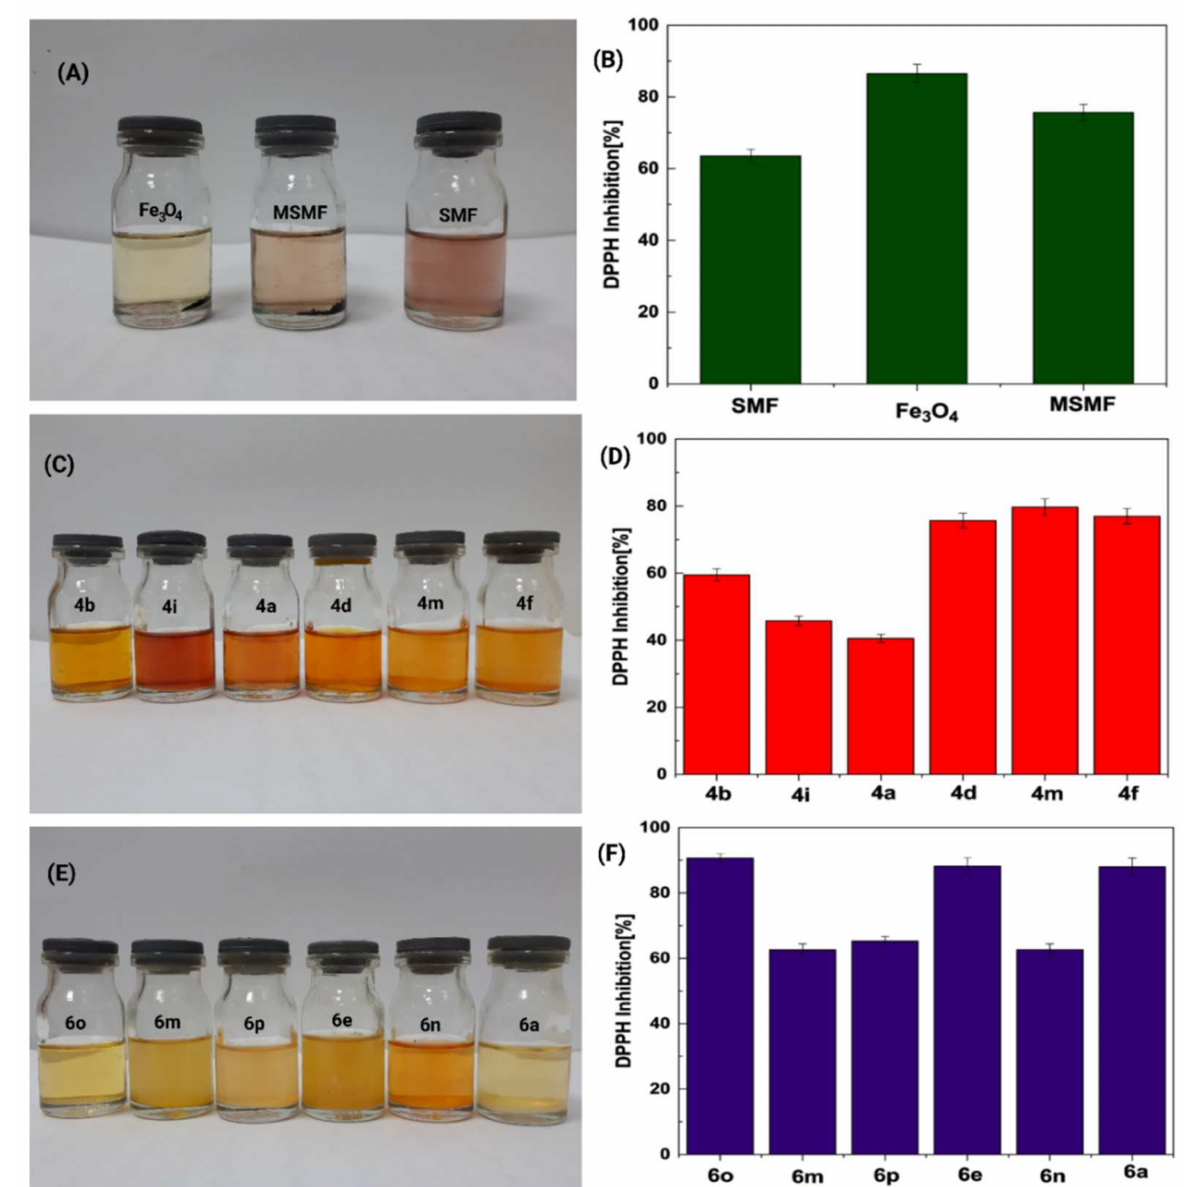
Figure 9. Photographs ( A , C , E ), and histograms of antioxidant activities of Fe 3 O 4 nanoparticles, SMF, MSMF ( B ), synthesized benzyl pyrazolyl naphthoquinone ( D ), and 4-[(indol-3-yl)-arylmethyl]-1- phenyl-3-methyl-5-pyrazolones ( F